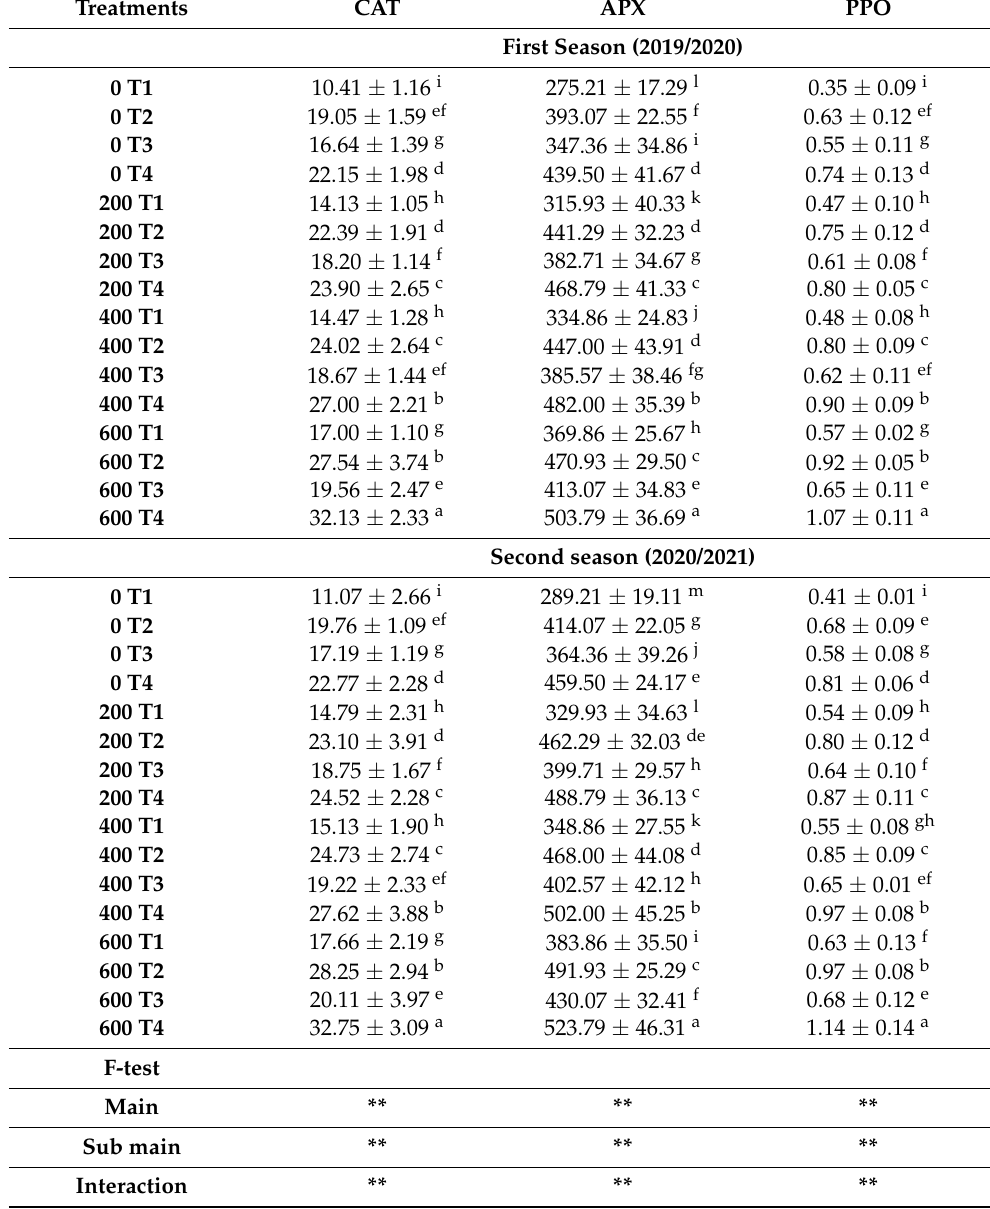
Table 3. Interaction effect of different concentrations of Ni and bacterial inoculation on catalase